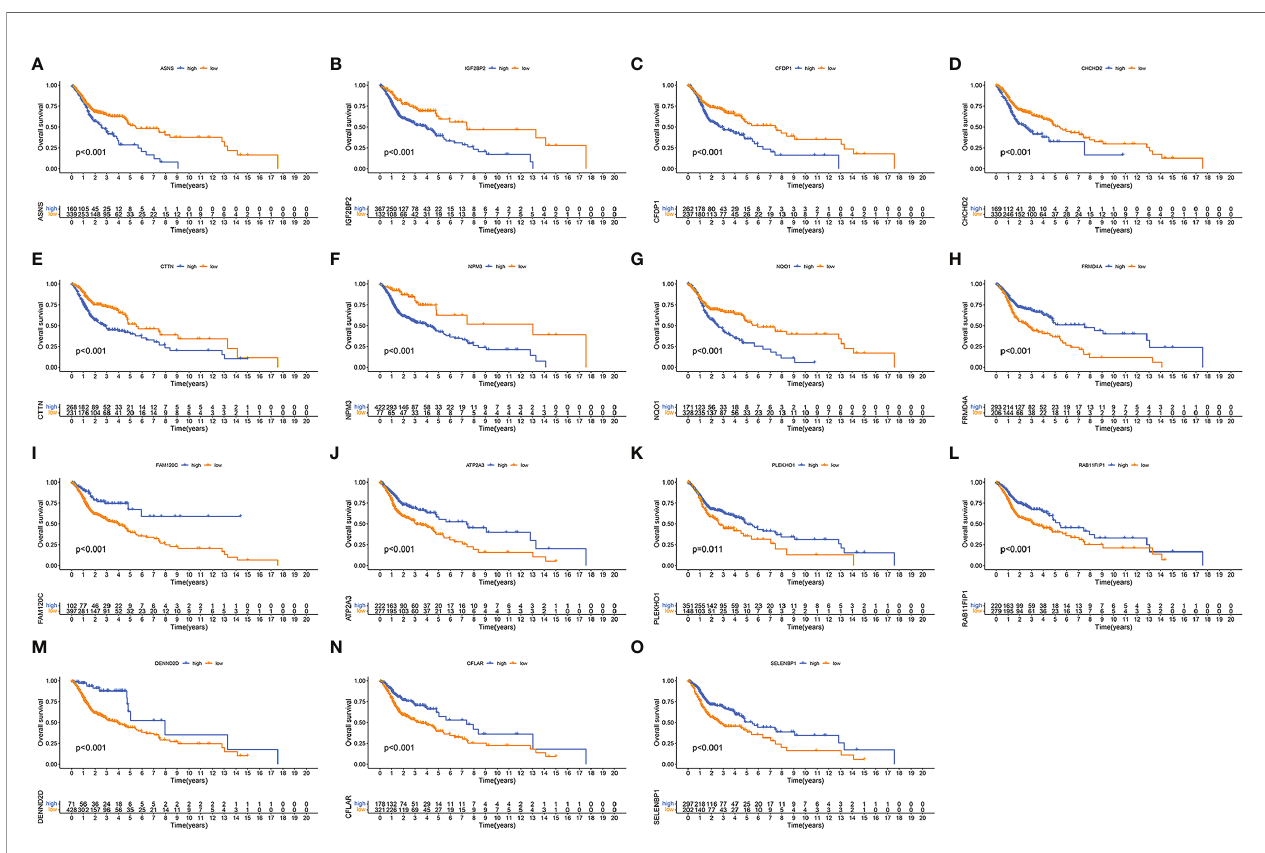
FIGURE 6 | Validation of each immune-related RNA-binding protein (RBP) in the risk model. Kaplan – Meier curves showing the differences of overall survival in high- and low-expression immune-related RBPs ASNS (A) , IGF2BP2 (B) , CFDP1 (C) , CHCHD2 (D) , CTTN (E) , NPM3 (F) , NQO1 (G) , FRMD4A (H) , FAM120C (I) , ATP2A3 (J) , PLEKHO1 (K) , RAB11FIP1 (L) , DENND2D (M) , CFLAR (N) , and SELENBP1 (O) between high-expression (blue) group and low-expression (yellow)